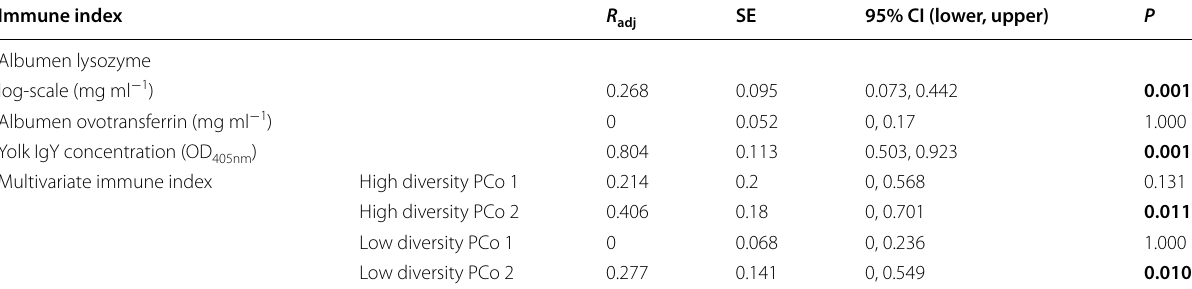
Bold values denote significant effects (alpha